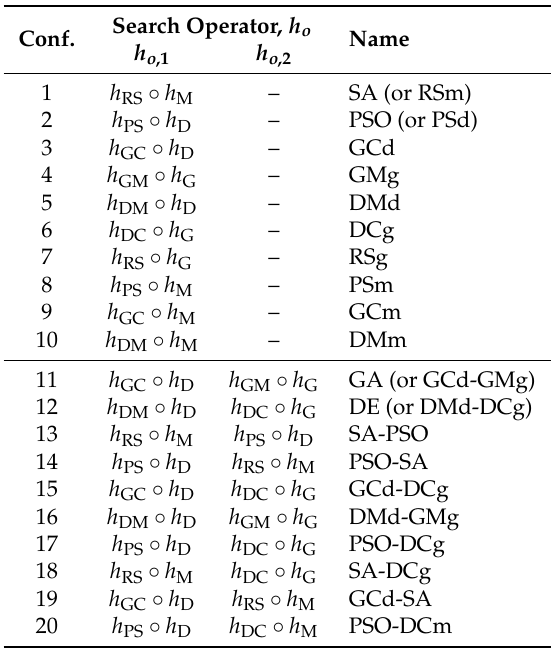
Table 4. Metaheuristics built by defining the cascade sequence of search